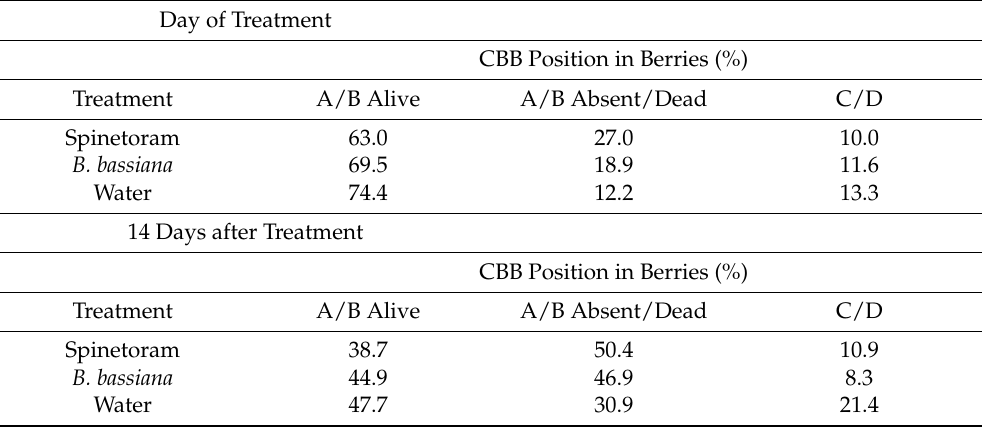
Table 2. Coffee berry borer (CBB) position in all infested berries on the day of treatment and 14 days after treatment with spinetoram, Beauveria bassiana , or water. Day of Treatment CBB Position in Berries (%) Treatment